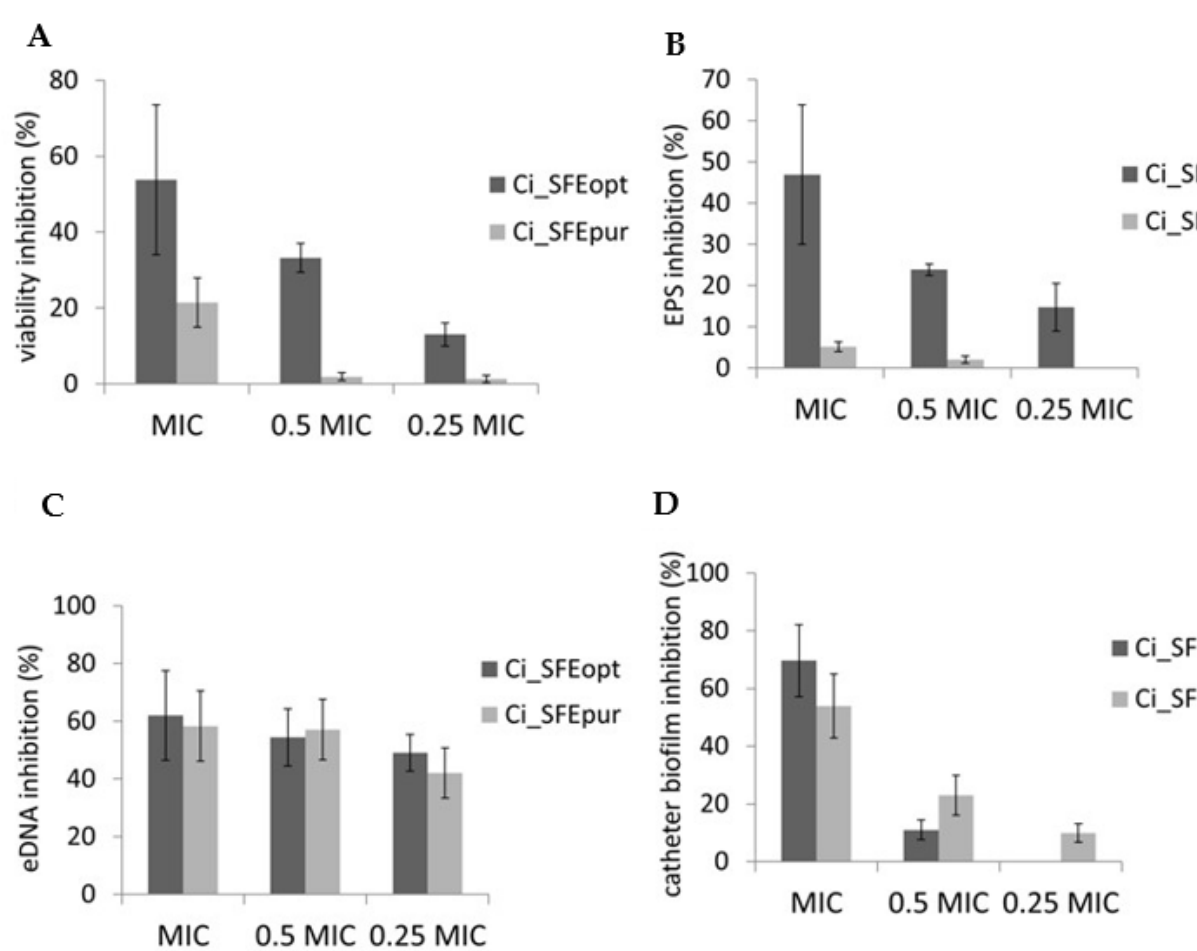
Figure 4. Modes of antibiofilm activity against P. aeruginosa IBRS P001 expressed as percentage inhibition compared to the untreated control. ( A ) Inhibition of biofilm cell viability determined by MTT assay. ( B ) Inhibition of biofilm exopolysaccharide content. ( C ) Inhibition of biofilm eDNA. ( D ) Inhibition of biofilm CFU formed on urinary catheters. Results are expressed as mean (±stdev) of triplicates.